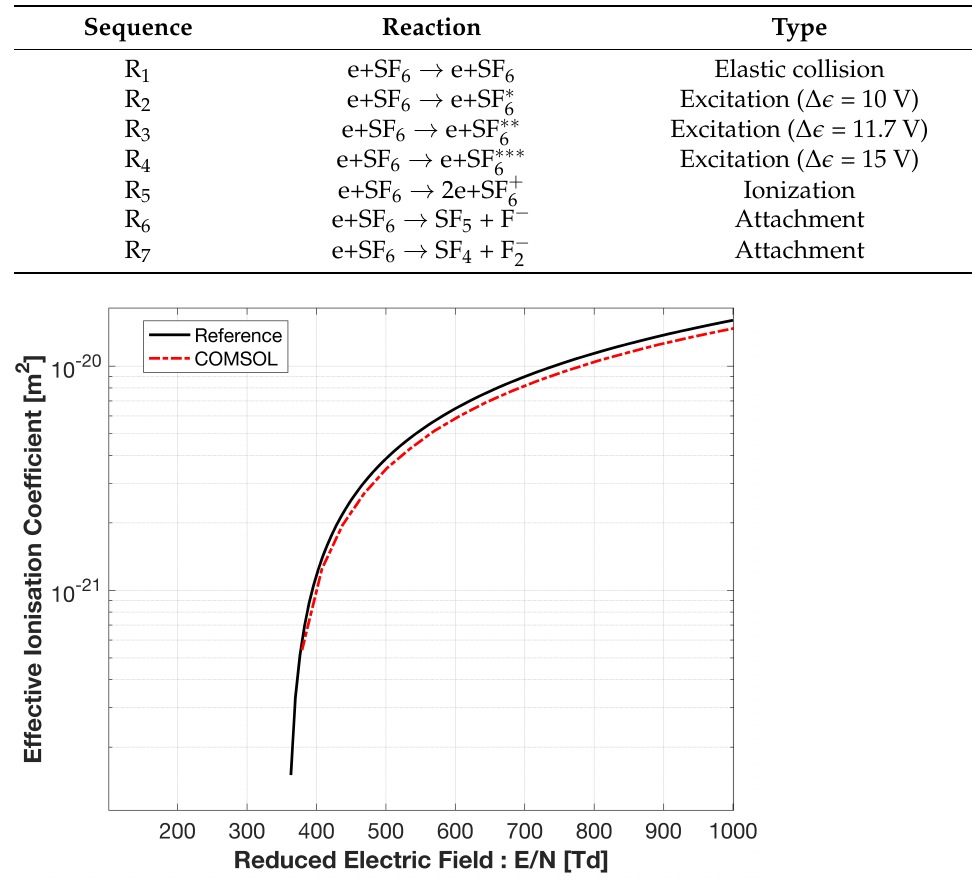
Figure 5. Normal and tangential electric field components on gas-solid insulator interface for initial (capacitive) field and transient behaviour after 4 weeks (672 h). Table 1. Electron-molecule reaction system for pure SF 6 .